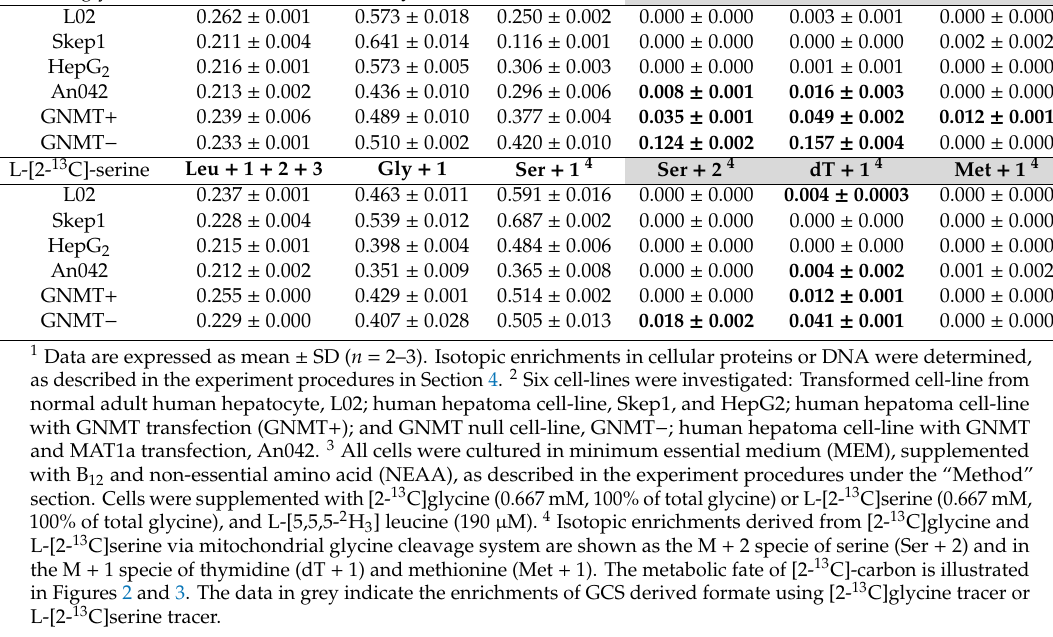
From GCS Derived Formate